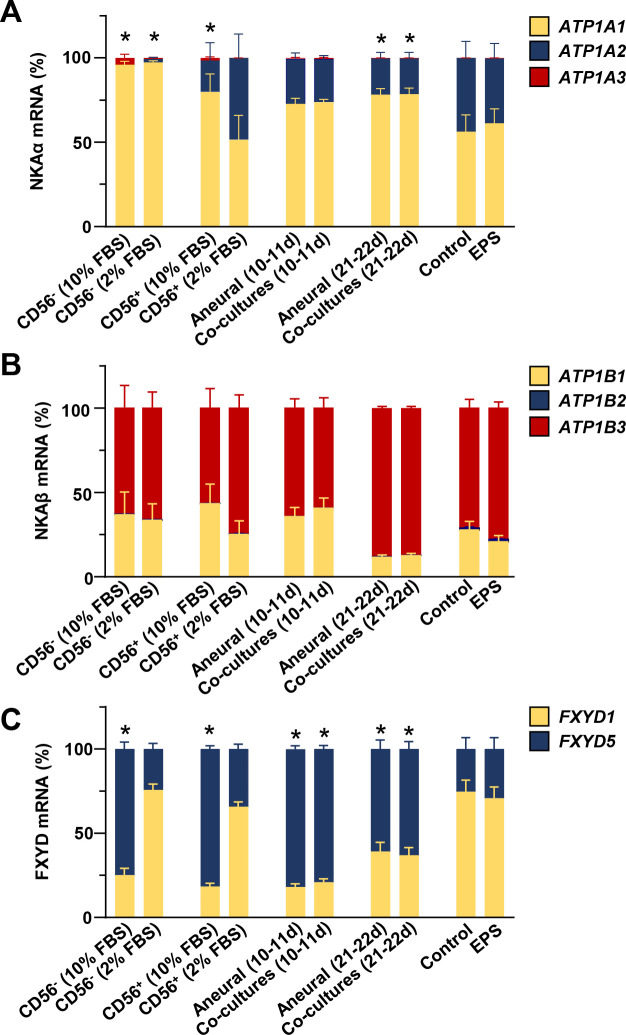
Relative expression levels of NKA subunits, FXYD1, and FXYD5 in different human skeletal muscle cell models.(A-C) Relative mRNA levels of (A) NKAα1–3 (ATP1A1-3), (B) NKAβ1–3 (ATP1B1-3), (C) FXYD1 and FXYD5 in different models were calculated based on results in Figs 1, 3, 6 and 7. CD56- and CD56+ cells were grown in the presence of 10 or 2% FBS as described in Fig 1. Co-cultures and aneural control cultures were grown in the presence of 10% FBS for 10–11 days (Fig 3) or 21 days (Fig 3) or 22 days (Fig 6). EPS was performed during the last 2 days of differentiation in the presence of 2% FBS (Fig 7). Expression level of NKAα1, NKAβ1, and FXYD1 mRNA were arbitrarily chosen as 1. Results are means ± SEM (n = 4–12 (co)cultures), *P<0.05 vs. CD56+ (2% FBS).